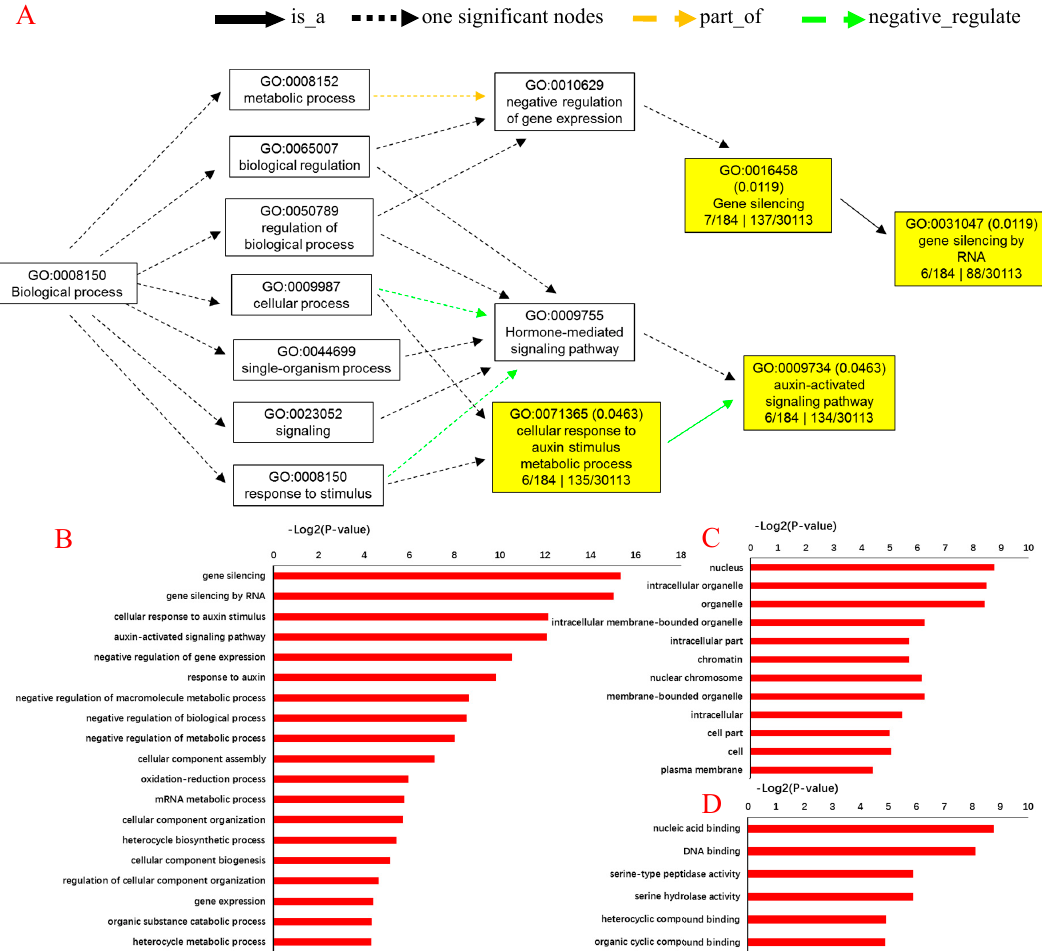
Figure 3. Gene ontology (GO) analysis for predictive targeted genes of differentially expressed miRNAs associated with internode elongation. Gene ontology enrichment analysis of biological process ( A ). − Log2 (P-value) of the corresponding biological process ( B ), cellular component ( C ), and molecular function ( D ). Log2 (P-value) is the negative logarithm of P-value; a bigger Log2 (P-value) indicates a smaller P-value. Detailed data are presented in Supplementary Tables S4 and S5.